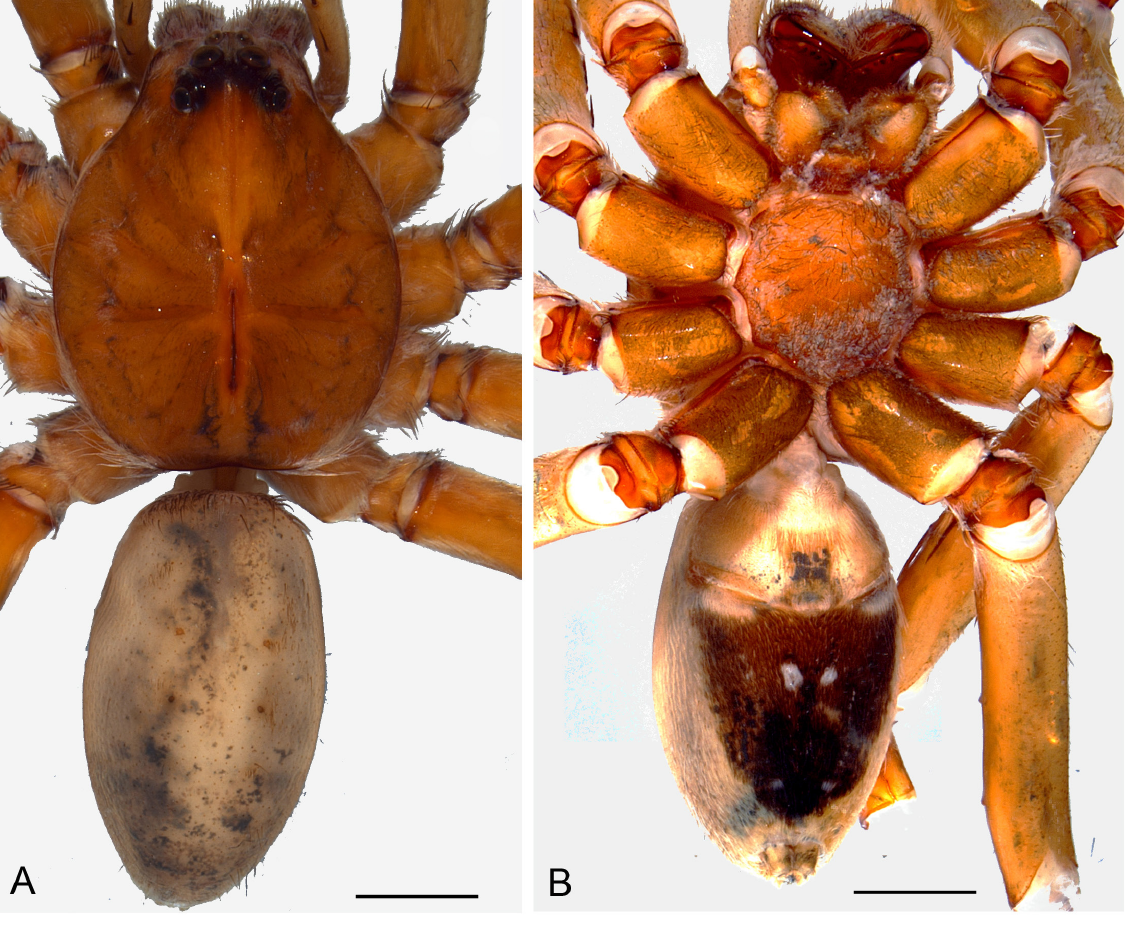
Fig. 10. Afroneutria hybrida sp. nov. Habitus, ♂. A . Dorsal view. B . Ventral view. Scale bars = 2